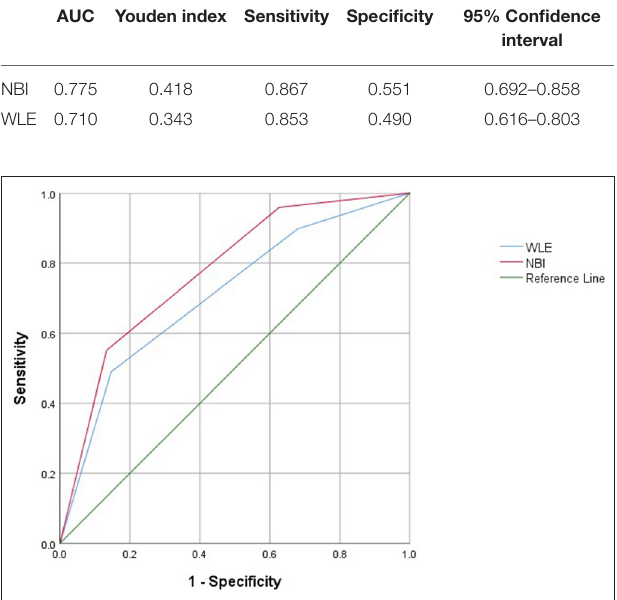
FIGURE 4 | Receiver operating characteristic curves of clinical recurrence assessed with WLE and NBI in patients with UC.